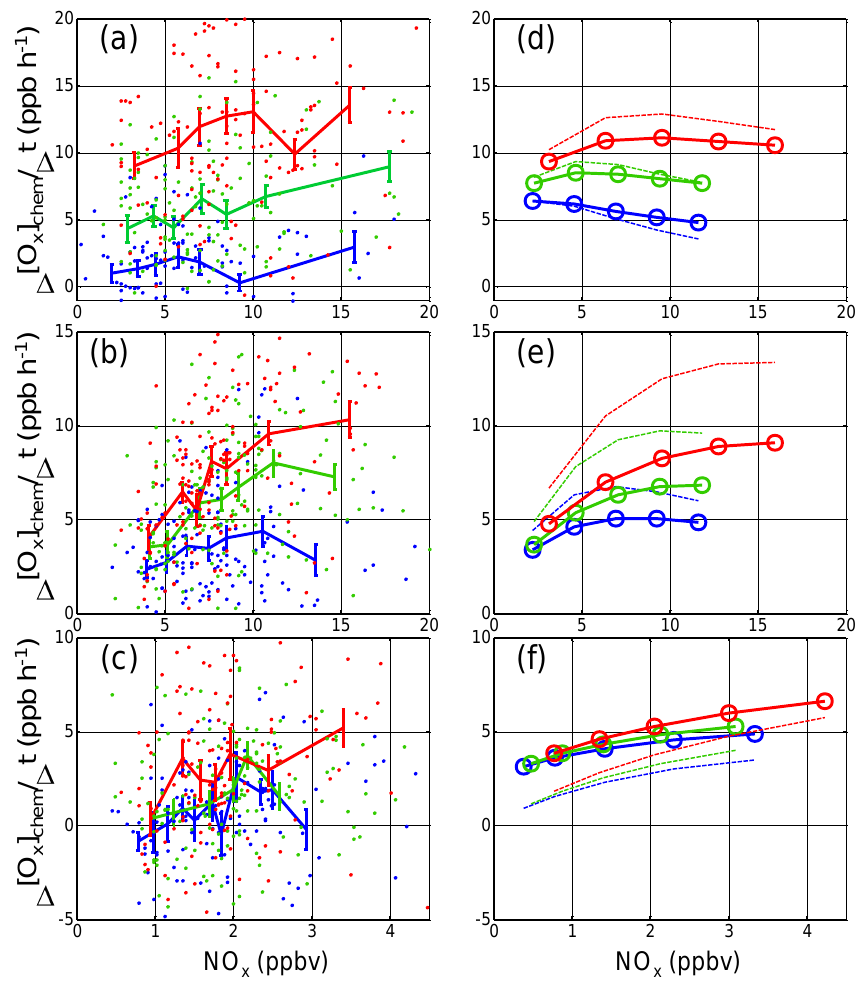
Fig. 3. Observed (a)–(c) and modeled (d)–(f) ozone production rates for three segments of Sacramento Urban Plume. Segment A, between Del Paso and Roseville, shown in (a) and (d) ; Segment B, between Roseville and Cool, shown in (b) and (e) ; Segment C, between Cool and UC-BFRS, shown in (c) and (f) . In all figures, plots are color coded by temperature range: red=high, green=medium, blue=low. See Sect. 4 for additional